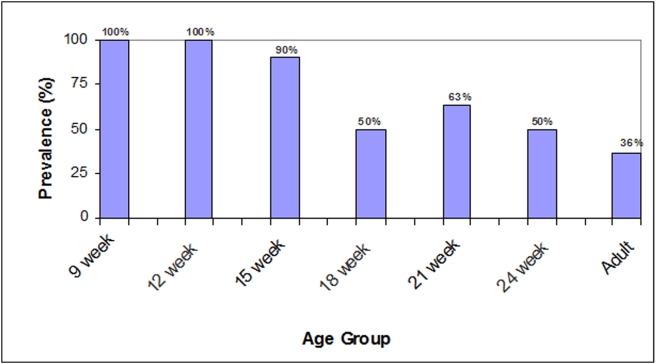
Prevalence of MRSA in swine from production system A by age aroup.